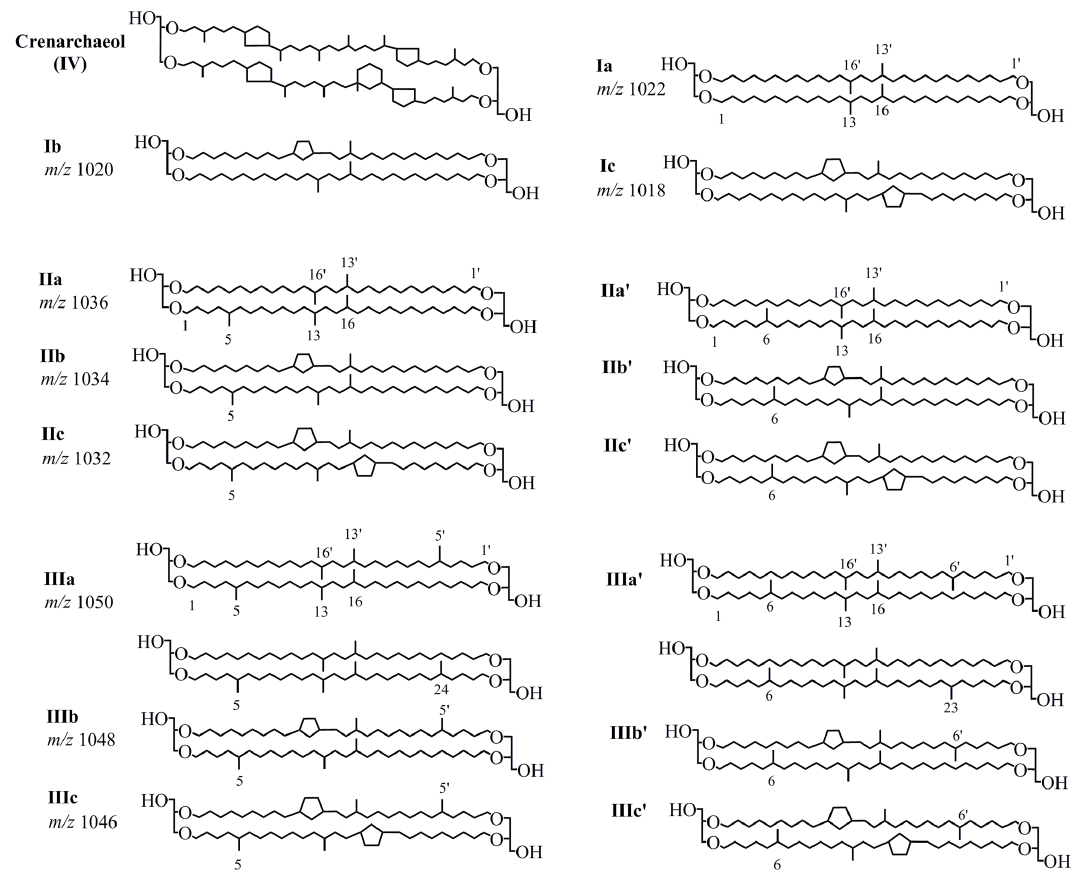
Figure 1. Chemical structures of branched GDGTs and